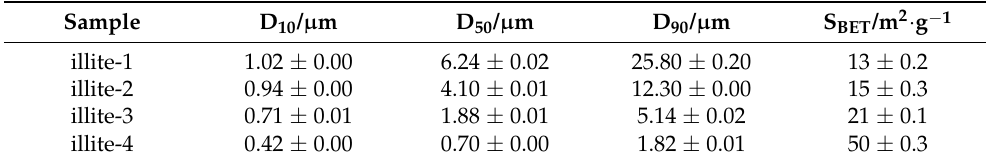
Table 2. Parameters of four different illite